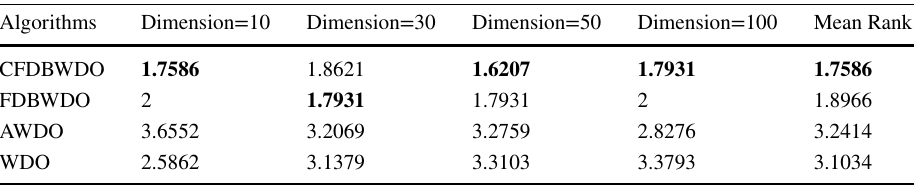
Table 5 Wilcoxon test comparison results for CFDBWDO and WDO